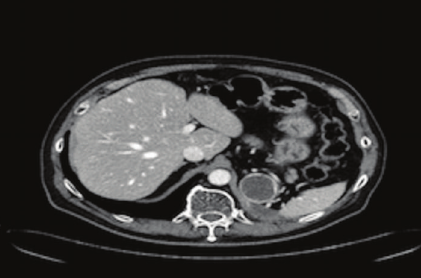
Figure 2: After 3 cycles of pazopanib the adrenal metastasis was stable in dimension but with more necrotic area.